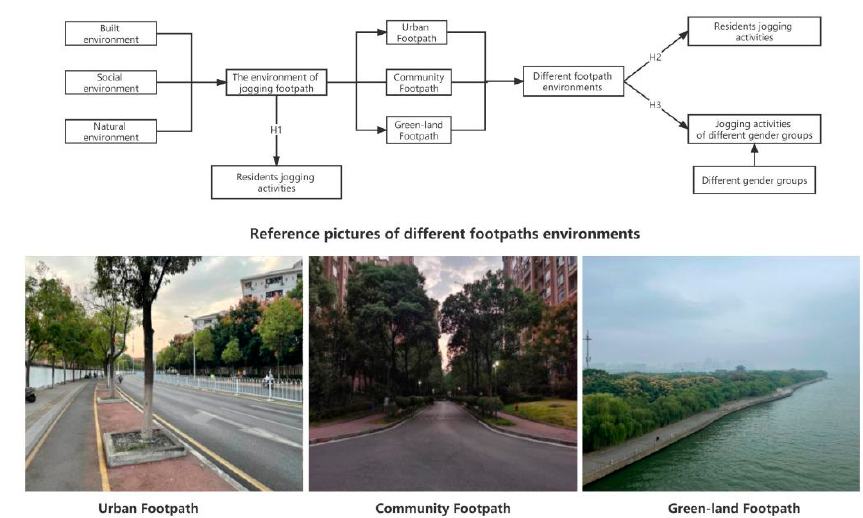
Figure 1. Theoretical Hypothesis Framework.